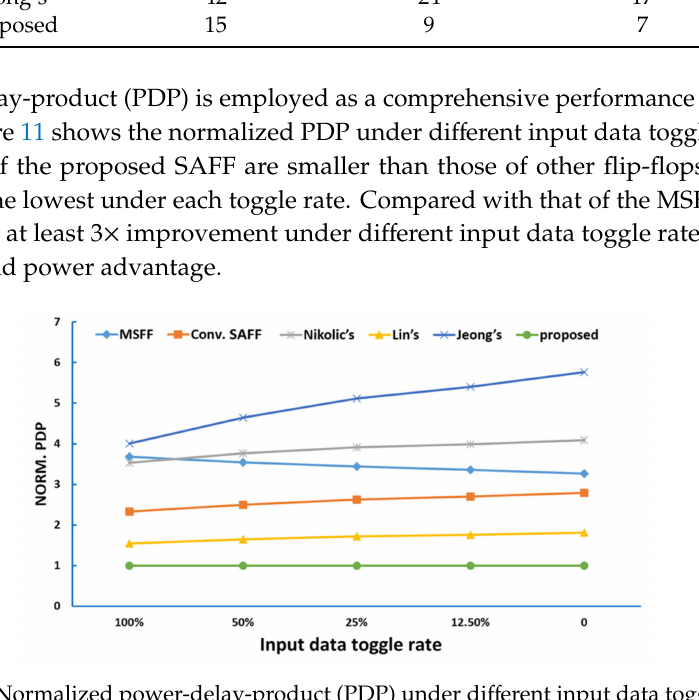
Figure 11. Normalized power-delay-product (PDP) under di ff erent input data toggle rates.